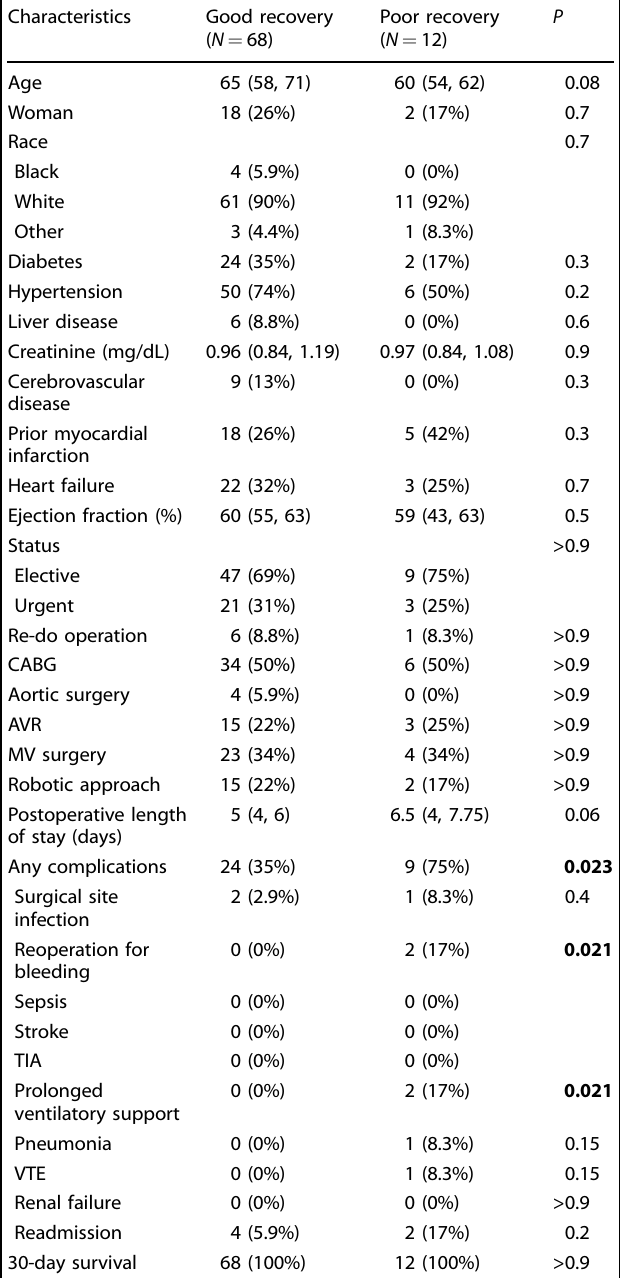
Table 1. Patient characteristics by the overall recovery trajectories.